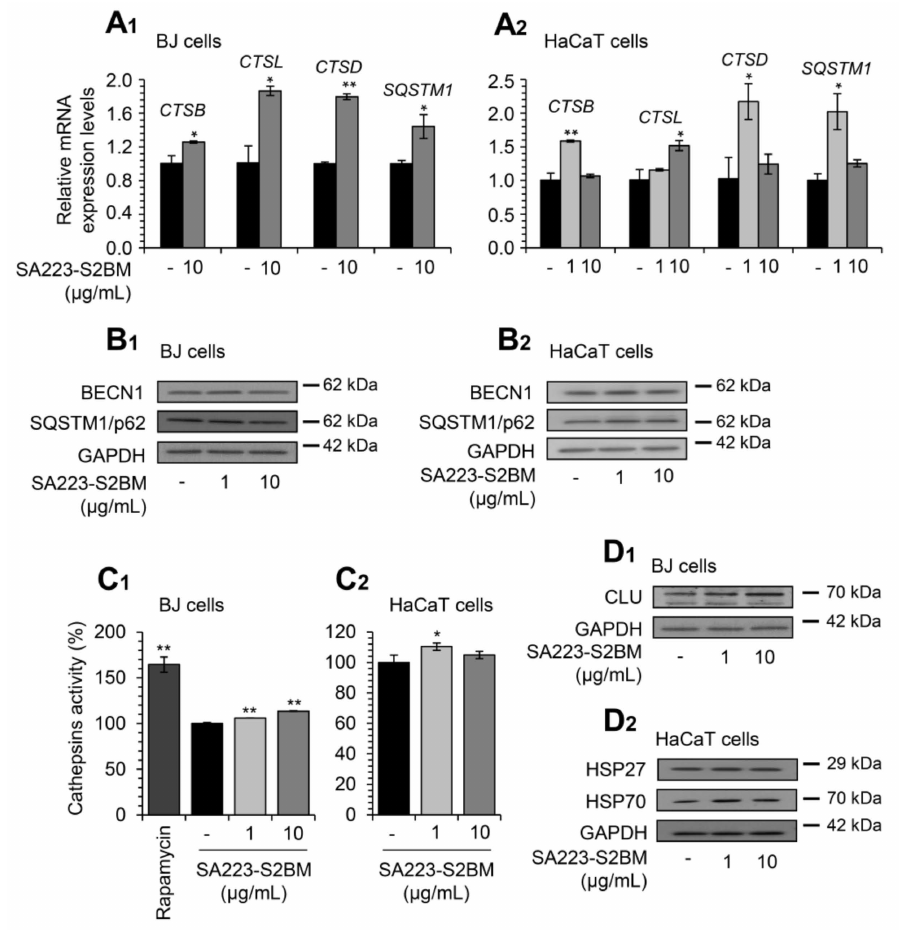
Figure 3. The extract SA223-S2BM activates ALP and induces the expression levels of molecular chaperones. ( A 1 , A 2 ) Q-RT-PCR expression analyses of genes involved in ALP functionality ( CTSB , CTSL , CTSD , SQSTM1 ) in BJ fibroblasts ( A 1 ) and HaCaT keratinocytes ( A 2 ), after exposure to the indicated concentrations of the SA223-S2BM extract for 24 h. ( B 1 , B 2 ) Representative immunoblotting analyses of the autophagy-related proteins BECN1 and SQSTM1/p62 expression levels after treatment of BJ ( B 1 ) and HaCaT ( B 2 ) cells with the shown concentrations of the extract for 24 h. ( C 1 , C 2 ) Relative (%) lysosomal-cathepsins activity in BJ ( C 1 ) and HaCaT ( C 2 ) cells, after 24 h treatment with the indicated concentrations of the extract. Rapamycin (100 nM) was used as a positive control. ( D 1 , D 2 ) Representative immunoblotting analyses of the molecular chaperones CLU, HSP27, and HSP70 expression levels after treatment of BJ ( D 1 ) and HaCaT ( D 2 ) cells with the shown concentrations of the extract for 24 h. HMBS gene expression ( A 1 , A 2 ) and GAPDH probing ( B 1 , B 2 , D 1 , D 2 ) were used as references for RNA and protein input, respectively. Quantitation of shown blots is presented in Figures S3 and S4. In ( A 1 , A 2 ), control samples values were set to 1; in ( C 1 , C 2 ), control samples values were set to 100%. Bars, ± SD ( n ≥ 2); * p < 0.05; ** p <